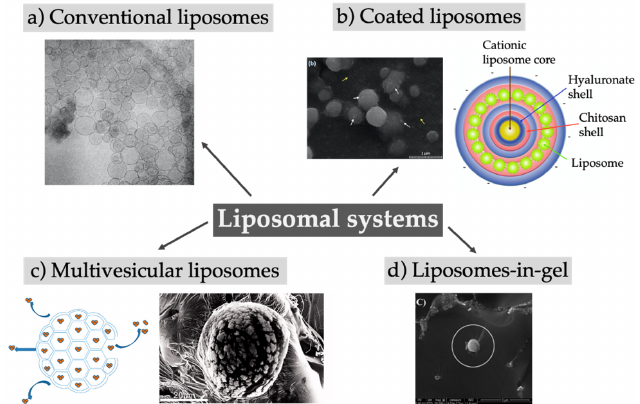
Figure 3. Overview of different approaches using liposomal systems like large unilamellar liposomes ( a ), multivesicular liposomes ( c ), liposomes with different coatings creating core-shell-systems ( b ), or the embedding of liposomes in gels ( d ). ( a ) Reprinted from [55]; ( b ) Reprinted from [56] and ( d ) reprinted from [57] with permission from Elsevier; ( c ) Adapted from [50,58]. Table 3. Overview of sustained release systems based on liposomes.